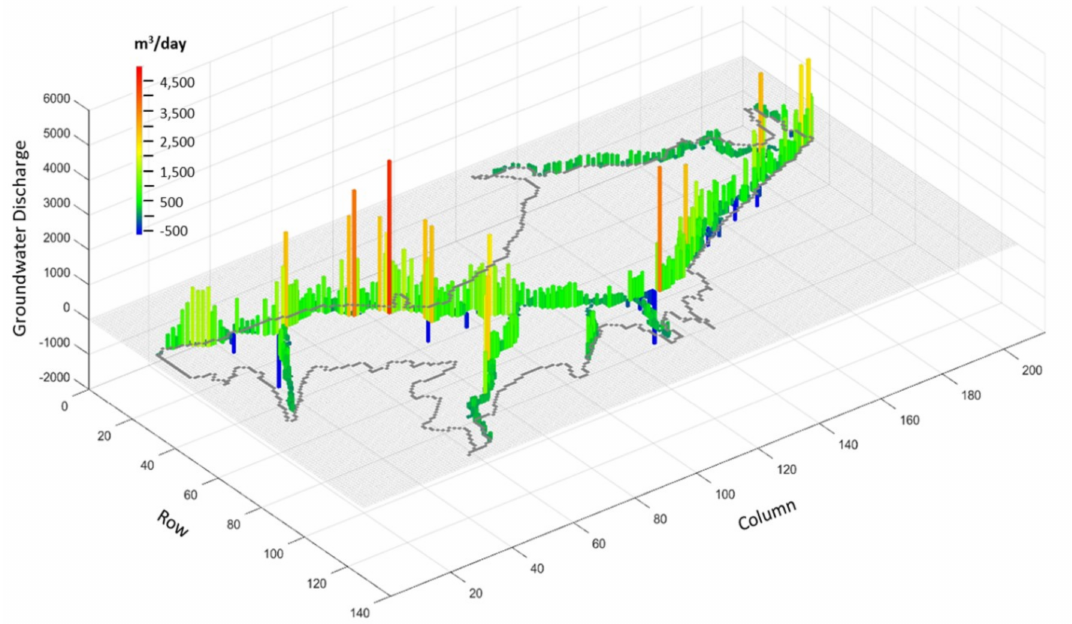
Figure 11. Three-dimensional (3D) simulated annual average groundwater discharge (m 3 / day) from the aquifer to the Arkansas River network over the 1999–2016 time